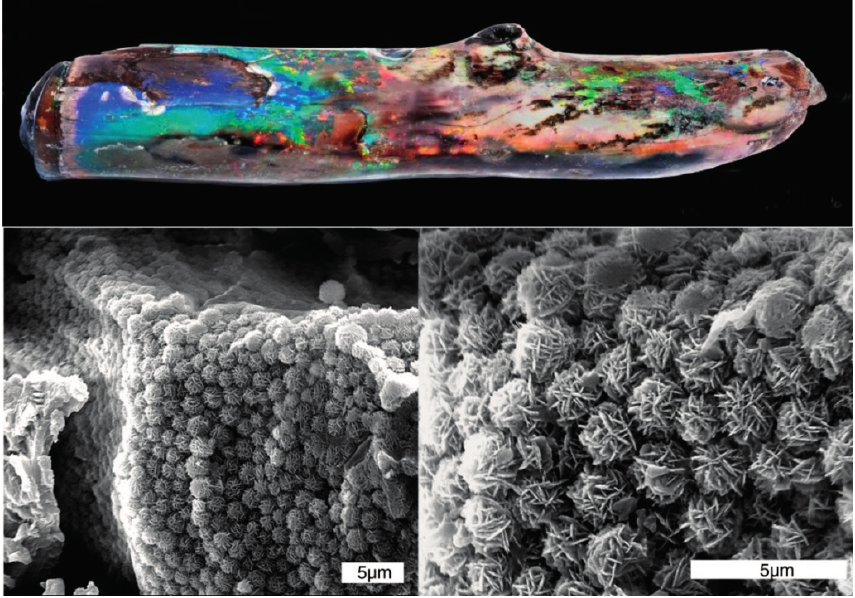
Figure 2. Twig mineralized with precious opal from Royal Peacock Mine, Virgin Valley, Nevada. SEM photos show well-ordered ordered stacking of opal-CT lepispheres that cause the iridescent reflectance. This structural order, not the opal species, that is the cause of “fire” in precious opal; Australian precious opal is typically composed of